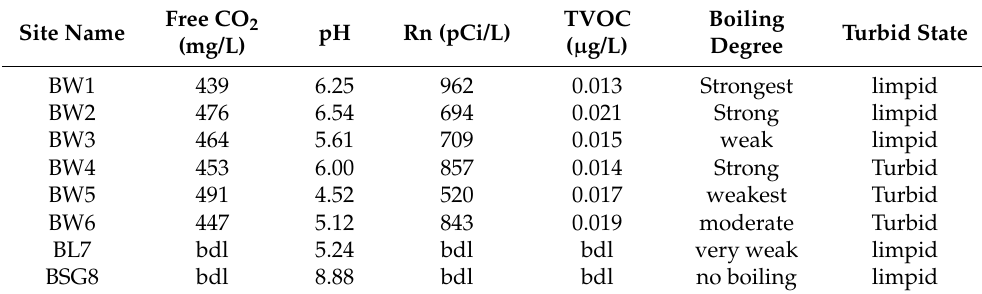
Table 1. Average contents of different gases in water samples and their boiling degree and turbidity state 1